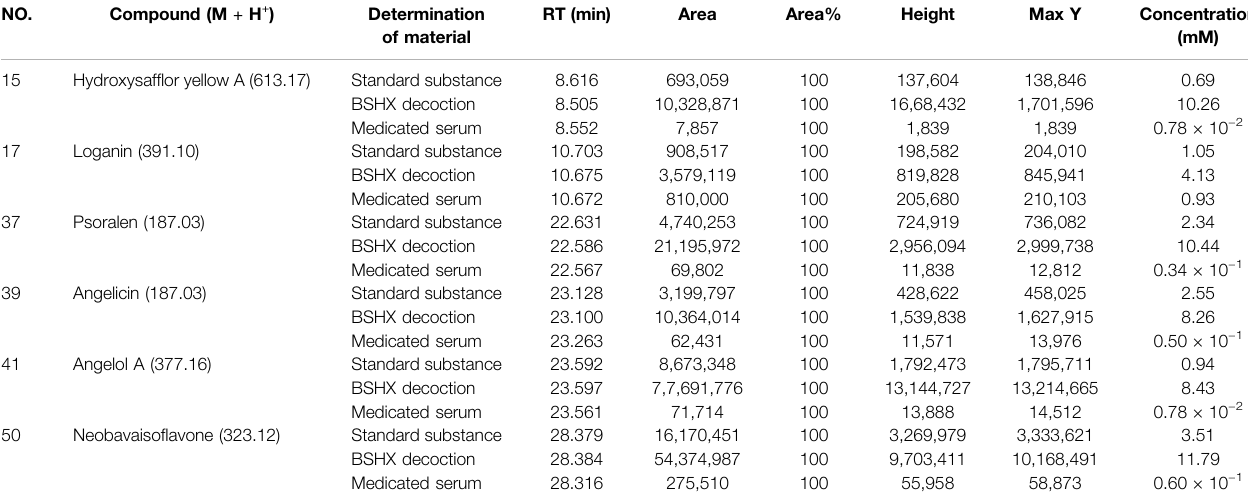
TABLE 2 | Quantitative analysis information of six compounds in BSHX decoction and the medicated serum. NO.